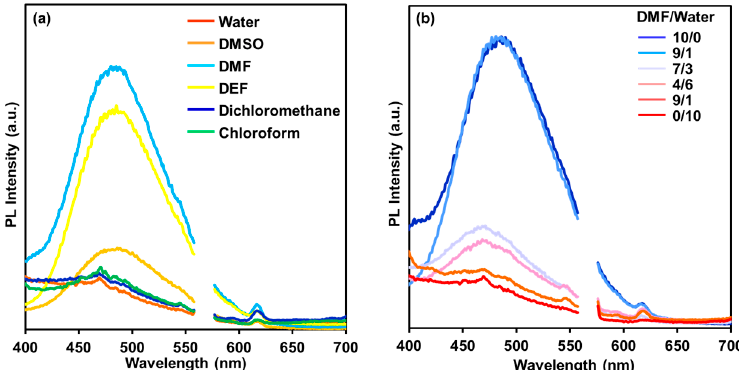
Figure 4. ( a ) Photoluminescence (PL) spectra of KUCCG(TPE) in various solvents ( λ ex = 280 nm); ( b ) Photoluminescence spectra of KUCCG(TPE) in mixed solvents of DMF and water (10/0 → 0/10, λ ex = 280 nm). The spectra between 555 and 575 nm are omitted due to scattering light derived from the excitation light.